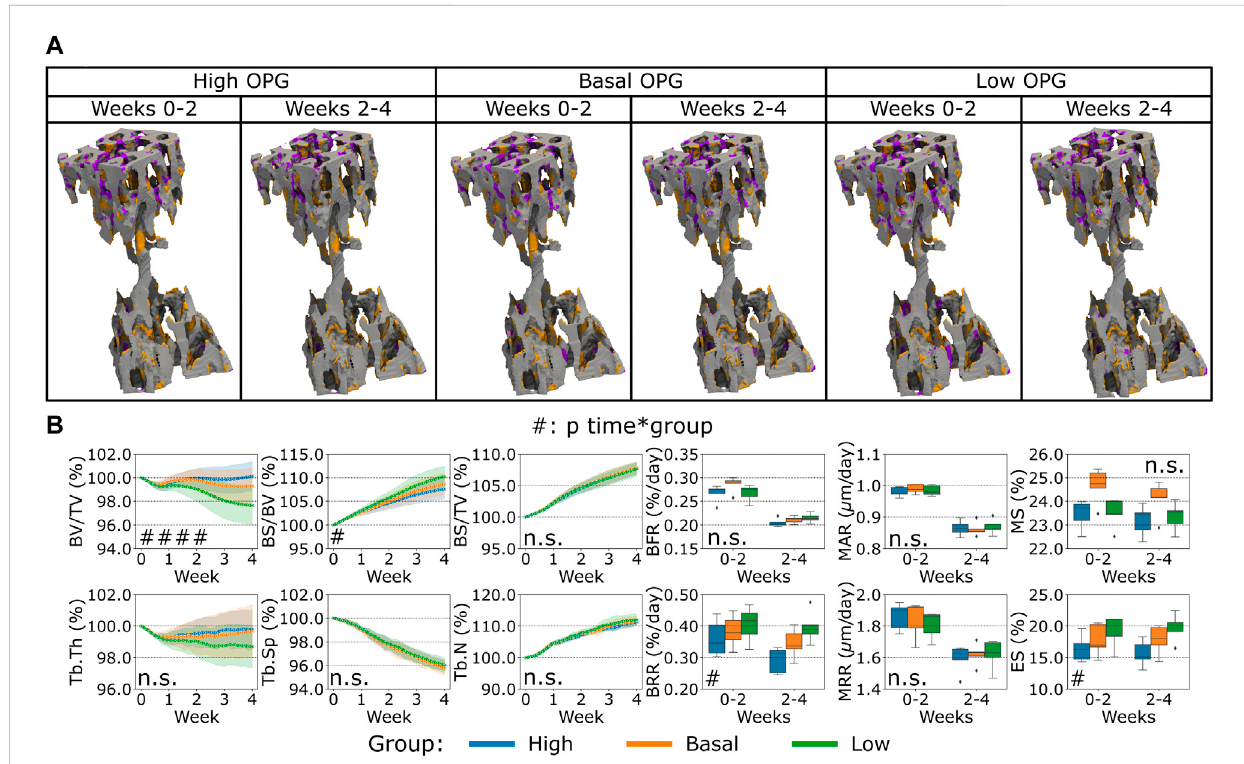
FIGURE 4 Insilico resultsofvariationsofthemaximumsinglecellproductionlevelofosteoprotegerin(OPG)byosteocytes. (A) BiweeklyFQRregionsofresults obtained with higher and lower OPG productions levels for the representative mouse (number 5). Bone formation in orange, quiescence in gray, and resorptioninpurple. (B) Staticanddynamicbonemorphometryparametersoftheresultsofthesimulationsofthesamegroupofmice( n =5)underthree different production levels of OPG, starting from the same initial condition of the basal level. High = higher production level of OPG, Basal = basal production level of OPG as in the homeostatic con fi guration, low = lower production level of OPG. (# p < 0.05, ## p < 0.01, ### p < 0.001, #### p < 0.0001 for the interaction time*group determined by two-way